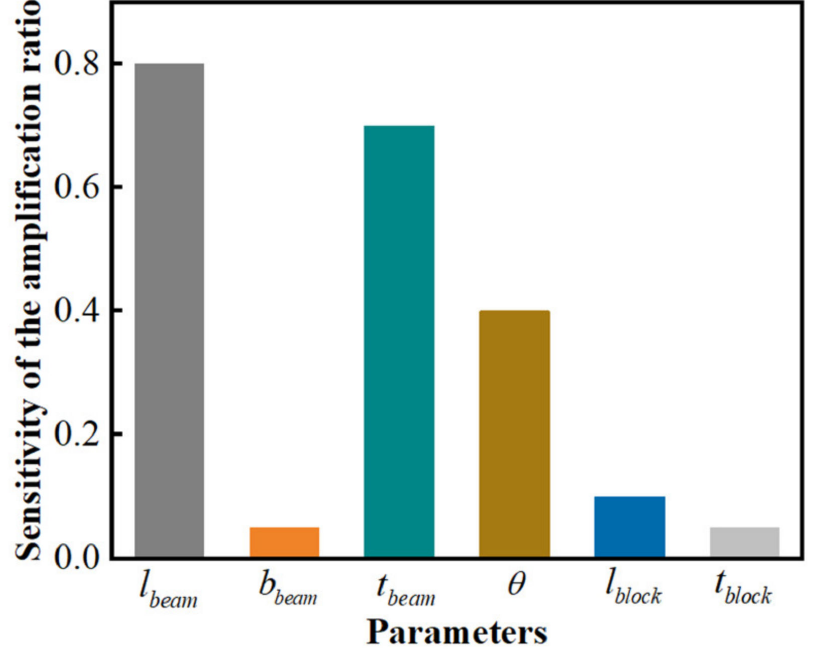
Figure 7. Sensitivity of dimensional parameters of a single frame to the amplification